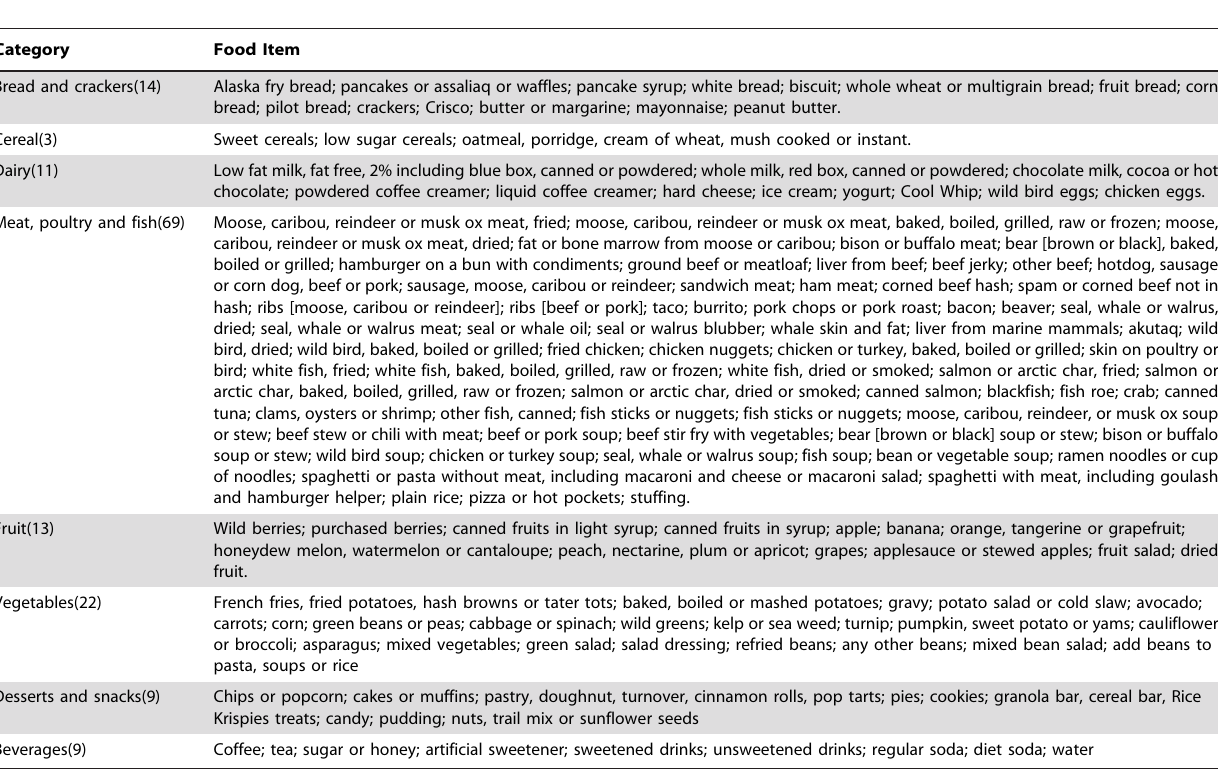
Table 3. Foods and beverages on the Quantitative Food Frequency